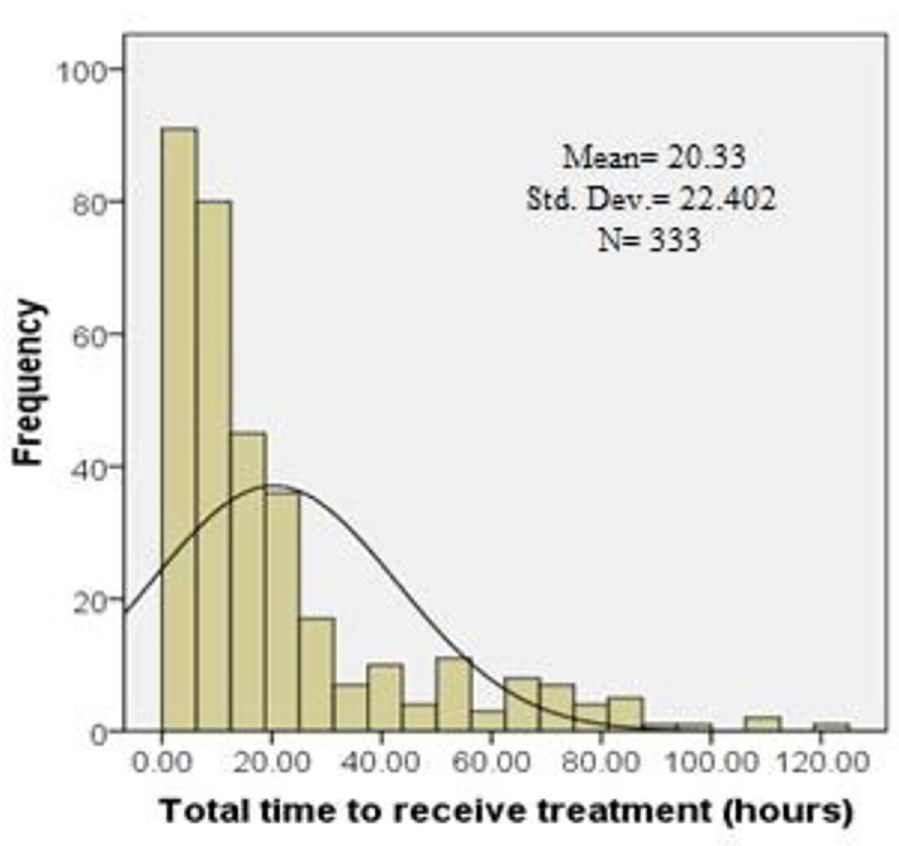
Fig 4. Histogram showing distribution of time to receive treatment with right